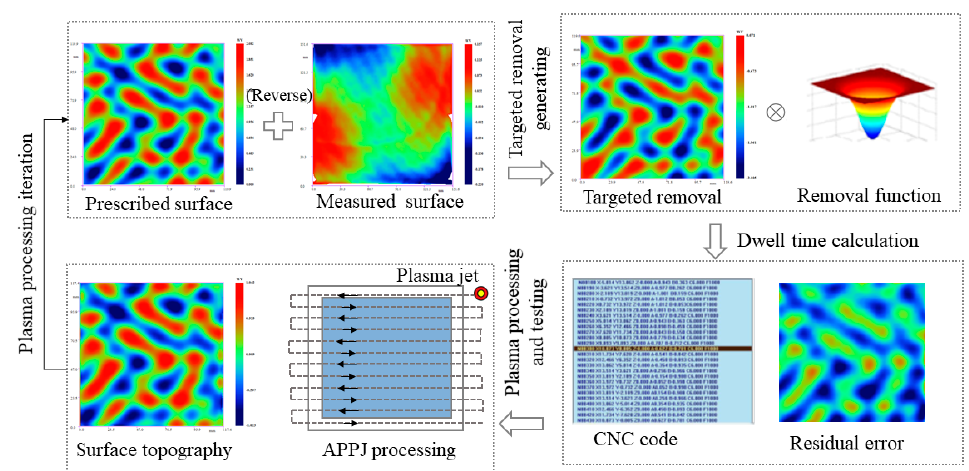
Figure 2. The fundamentals of APPJ processing.